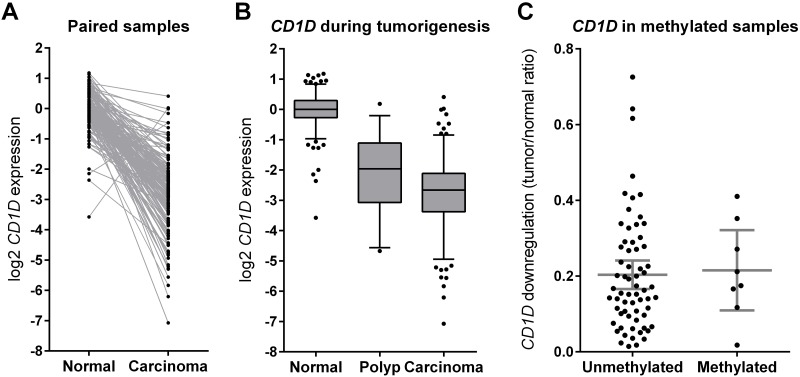
CD1D expression analyses in patient samples.qRT-PCR expression analysis of CD1D in 184 paired carcinoma and normal samples. A strong transcriptional downregulation was observed in the carcinoma compared to the normal samples. Gene expression values are relative to the median of the normal samples (4A). Comparison of CD1D expression in 34 polyp samples compared to the 184 normal and carcinoma samples. CD1D is also downregulated in the polyps, but downregulation in polyps is not as strong as in the carcinoma. Gene expression values are relative to the median of the normal samples. The box represent the 25-75-quartiles, the whiskers represent the 5–95% percentiles (4B). Comparison of the CD1D expression normal/carcinoma ratio in methylated versus unmethylated carcinoma. CD1D hypermethylation does not affect the degree of transcriptional downregulation. The bars represent the mean with 95% confidence interval (4C).